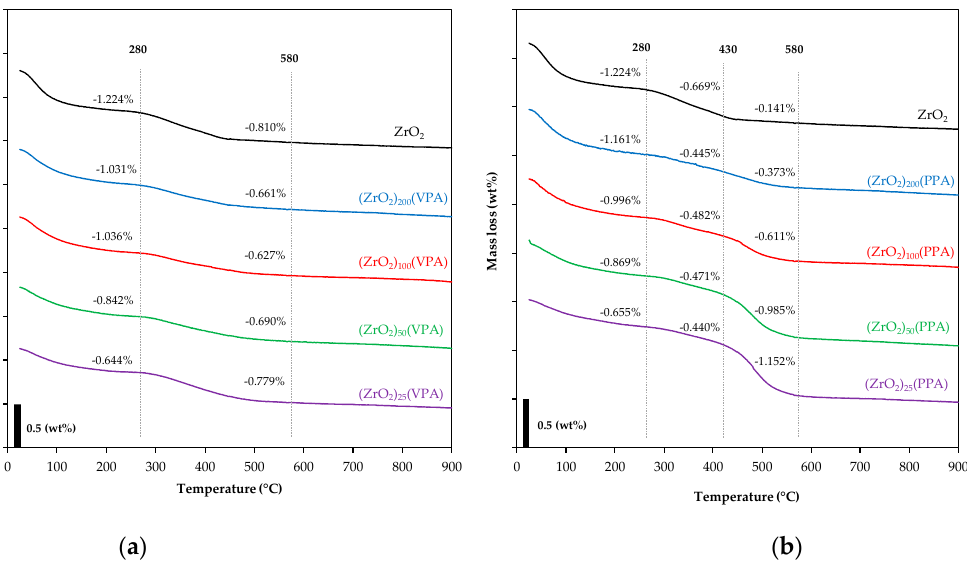
Figure 4. Thermogravimetric analysis of ( a ) (ZrO 2 ) x (VPA) and ( b ) (ZrO 2 ) x (PPA) samples (Zr/P ratio ( x ) = 25, 50, 100, 200) and bare ZrO 2 in the range of 25–900 °C.